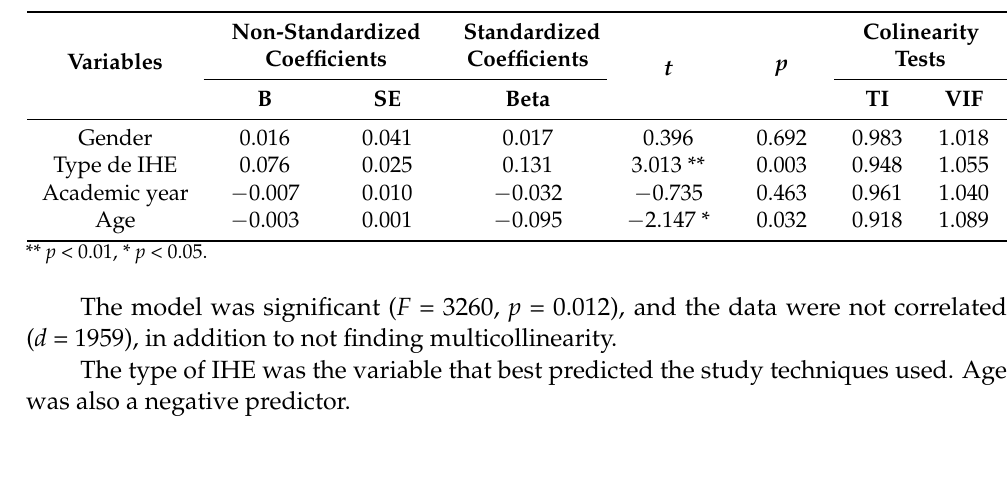
Table 7. Regression analysis regarding study